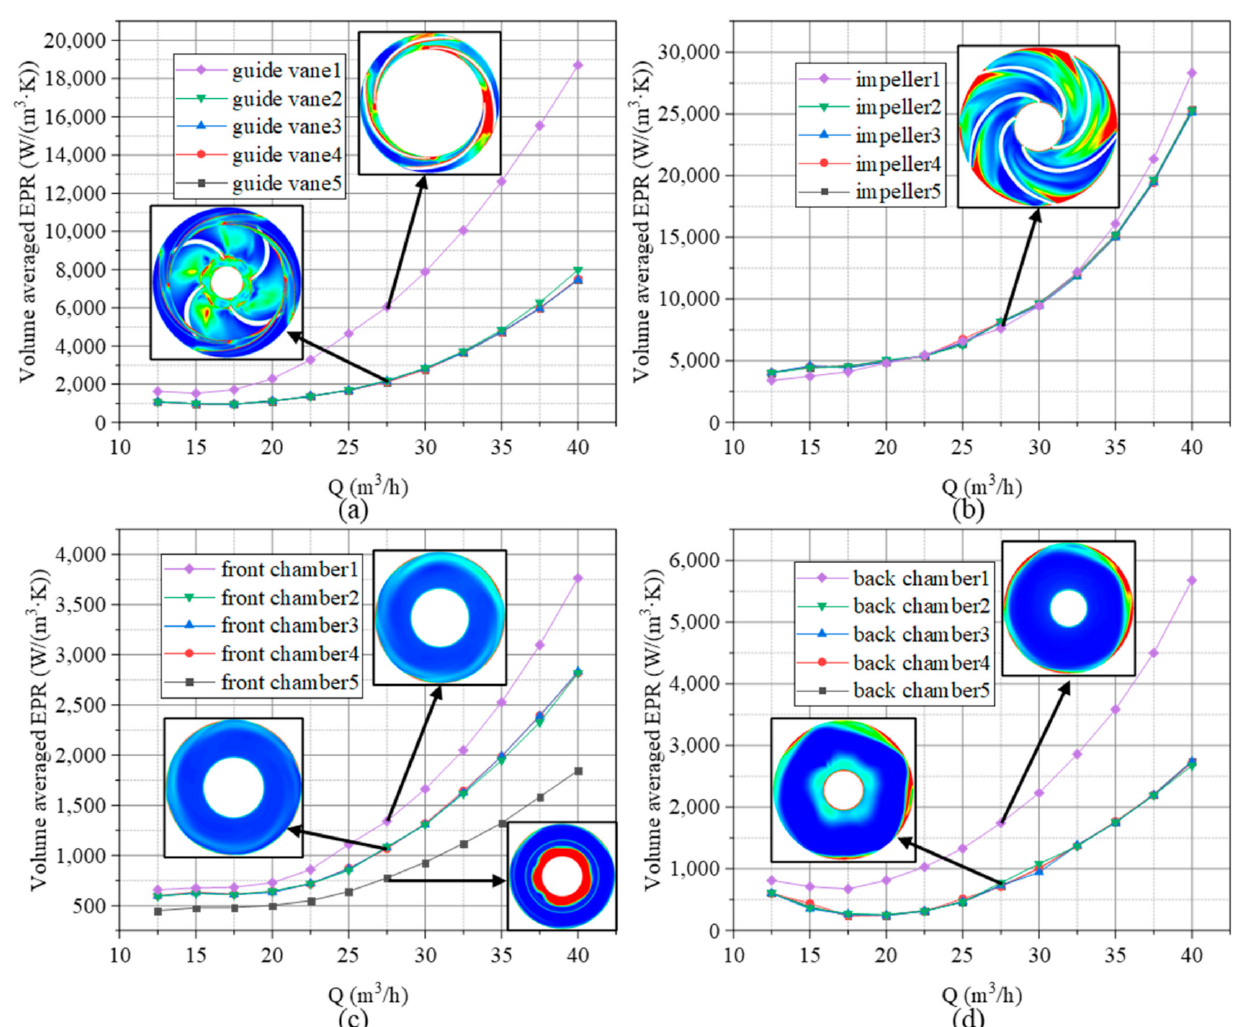
Figure 10. Comparison of volume averaged EPR of multi‑stage PAT of components in different stages: ( a ) guide vanes, ( b ) impellers. ( c ) front chambers. ( d ) back